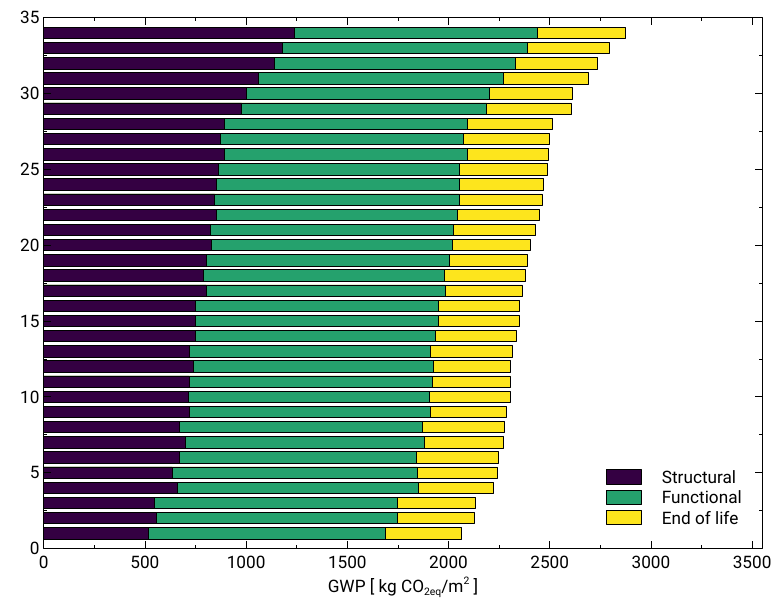
Figure 4. GWP ratio in CO 2 eq/m 2 of the 34 SFHs by life cycle